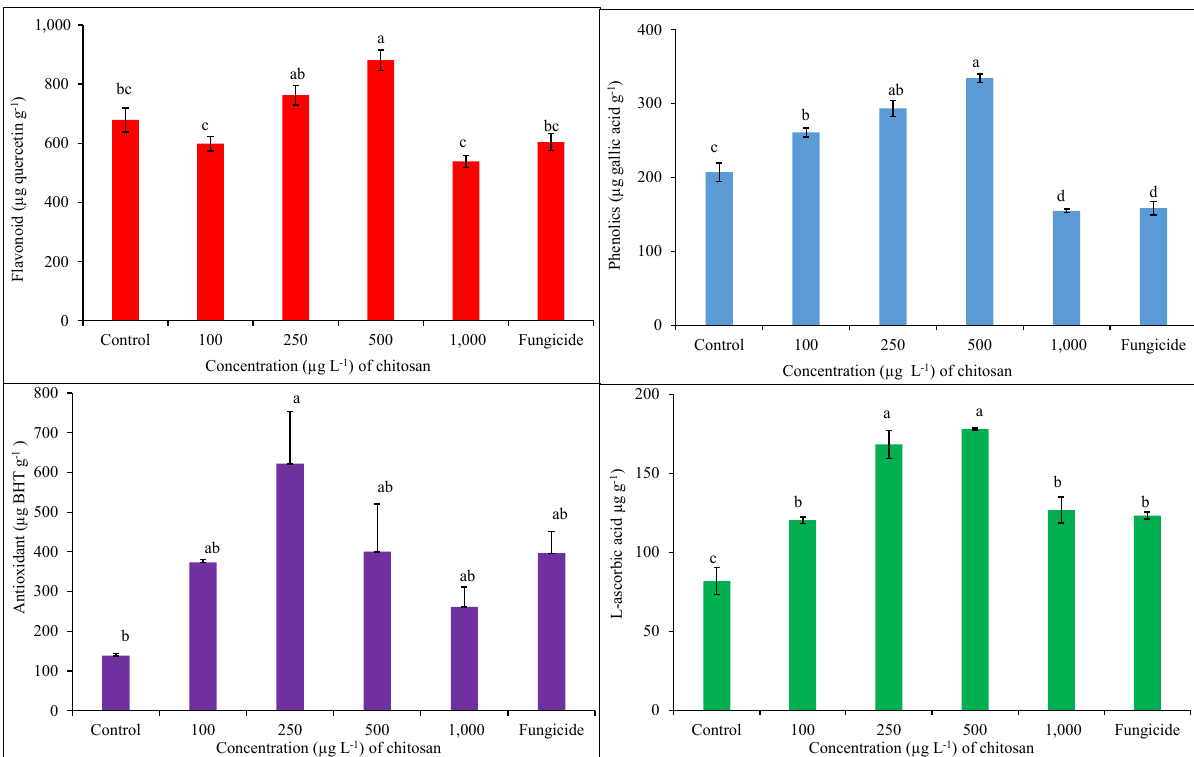
Fig. 2 Enhancement of ( A ) total flavonoids (µg quercetin equivalent g −1 FW), ( B ) phenolics (µg gallic acid equivalent g −1 FW) contents, ( C ) antioxidant activity (µg BHT equivalent g −1 FW), and ( D ) vitamin C content (µg ascorbic acid g −1 FW) of fresh litchi fruit by the treatment of varying doses of chitosan. One-way ANOVA was performed for analysis of the data and mean values in the bars followed by the same letter(s) are not significantly different as assessed by Fisher’s protected LSD (least significance difference) at p ≤